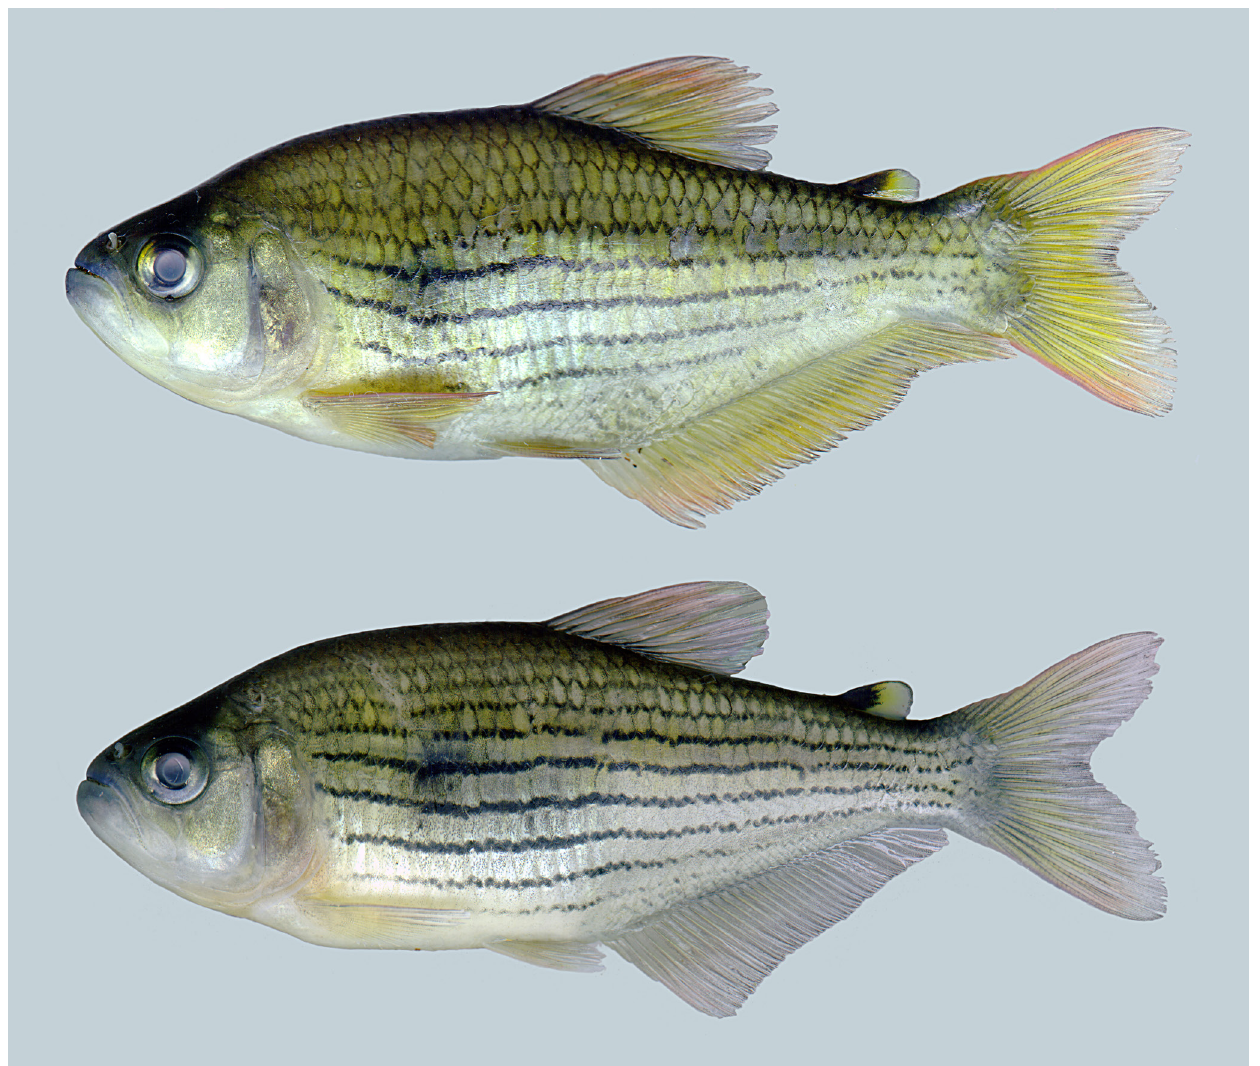
Fig. 7. Hollandichthys multifasciatus , MCP 30559, male, above, 85.8 mm SL, female, below, 73.0 mm SL, tributary of rio Quilombo, Quilombo, Cubatão, São Paulo